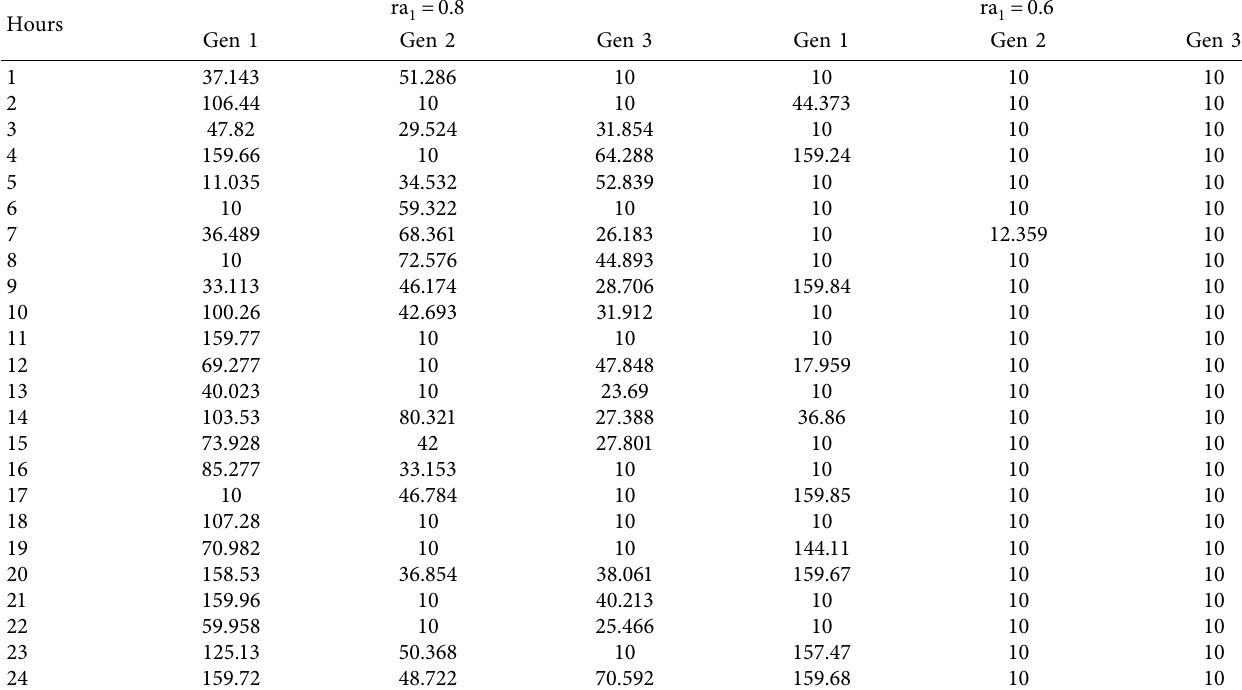
� 0.8 and ra � 0.6. 1 1